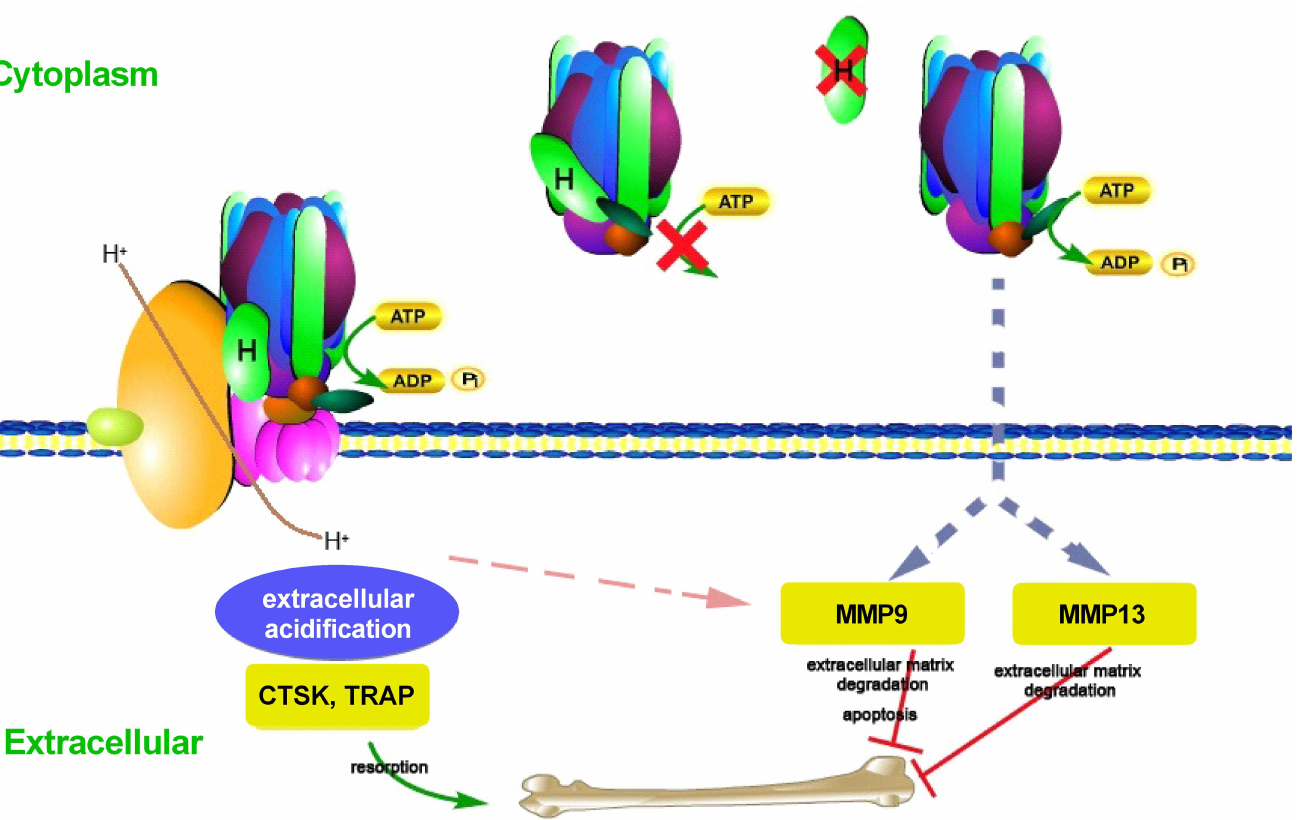
Fig 5. Model of action. A schema showingVacuolar ATPase and its subunits. Subunit H (V1, cytosolic domain) is shown in green. Under physiologic conditions, ATP hydrolysisoccurs in the cytosolic domainwhile proton translocation occurs through the membranedomain. The V1H